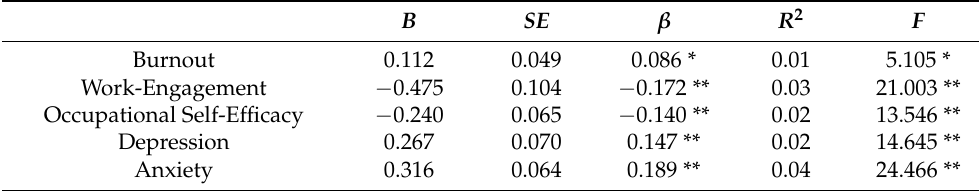
Table 6. Logistic regression for shift work predicting occupational health